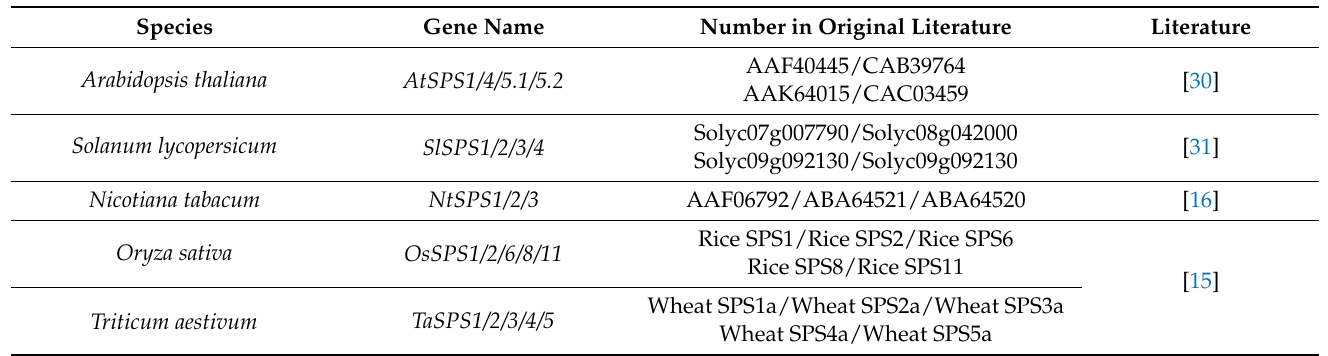
Table 4. Information and literature sources of SPS family members in various plants.